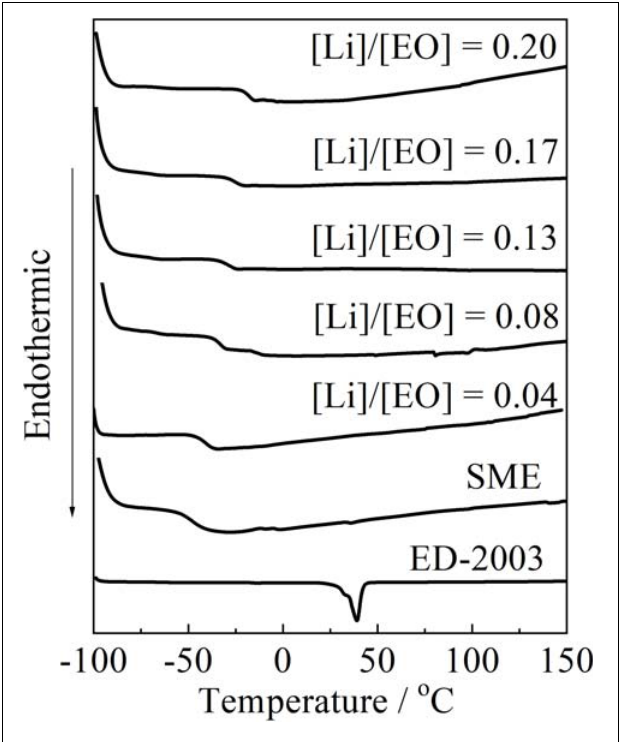
FIGURE 7 | DSC traces of ED-2003, SME, and SME/LiTFSA